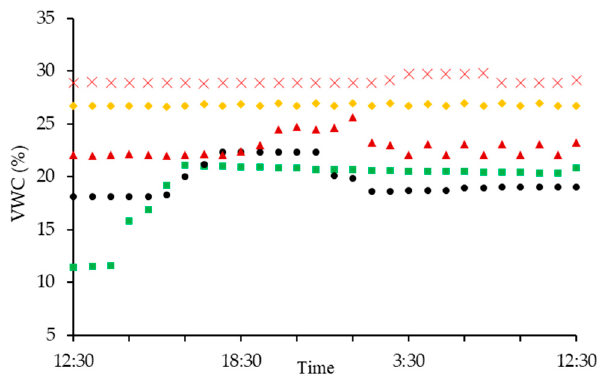
Figure 6. VWC at the slope gradient of 0° and the water application rate of 8.0 mm·h − 1 , with soil depths of 10 cm ( ■ ), 20 cm ( ● ) 30 cm ( ▲ ), 40 cm (×), and 50 cm ( ◆ ).